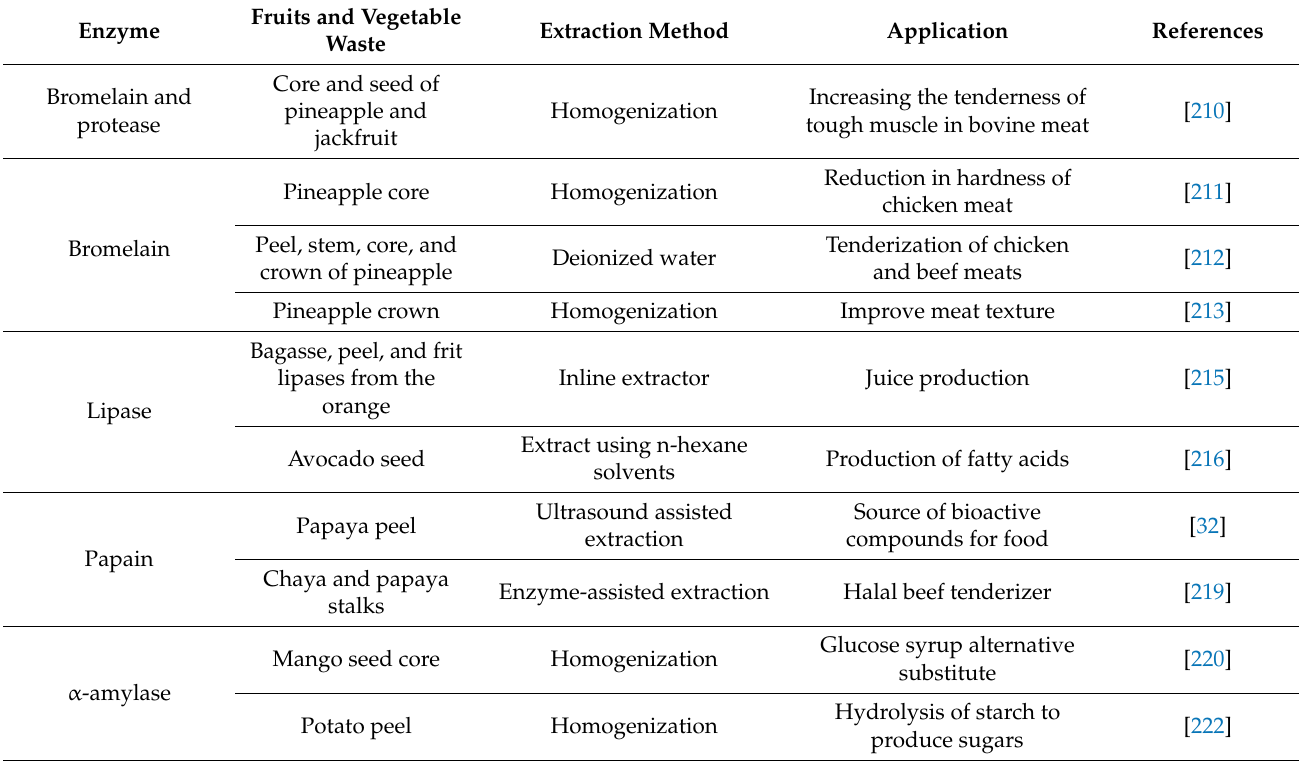
Table 7. Application of enzyme extract from fruit and vegetable waste in the food